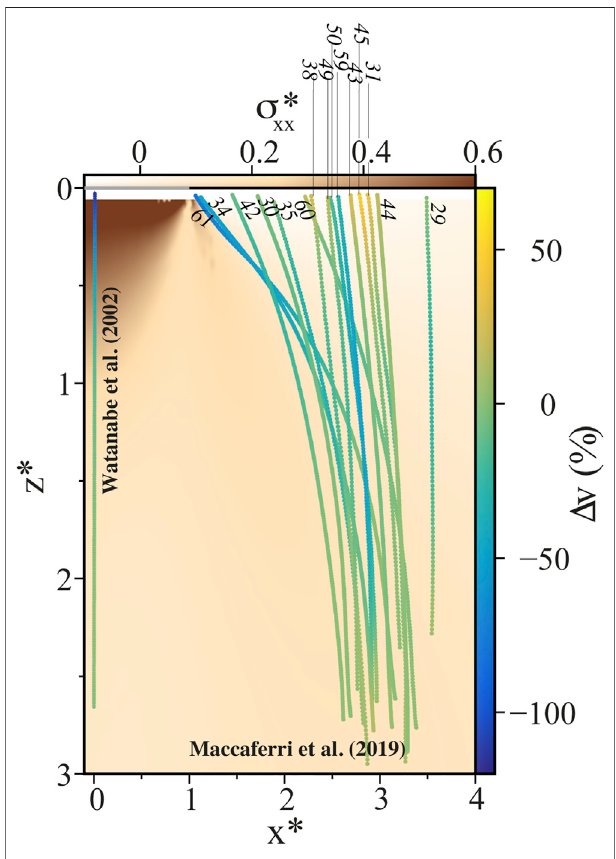
FIGURE 3 | Velocity variations along the trajectory followed by the ascending fl uid- fi lled crack recorded in analog experiments. The velocity variation is relative to the velocity of reference ( V ref ) de fi ned as the mean value of the velocity estimated over 1 cm at the bottom oftrajectory ( Figure 2 ; Table 1 for values of V ref ). Results from the 15 air injections described in Maccaferri et al. (2019) are represented (labels in italic are for the experiment number)togetherwiththeresultprovidedbyWatanabeetal.(2002)fora verticalascentbelowa210 Paload[ Figure7 ofWatanabeetal.(2002)]. The horizontal component ( σ xx * ) of the stress fi eld perturbation induced by the load applied at the surface is displayed in the background, it is normalized by the pressure applied at the surface. Compression is positive while tension is negative. Vertical and lateral dimensions are normalizedbythehalf-lengthoftheloadappliedatthesurface[i.e.,3and 4.5 cm, respectively, for experiments described in Maccaferri et al. (2019) and Watanabe et al. (2002)]. Note that this normalization of distances is different from that used in Maccaferri et al. (2019). The grey line at z * = 0 is for the position of the applied